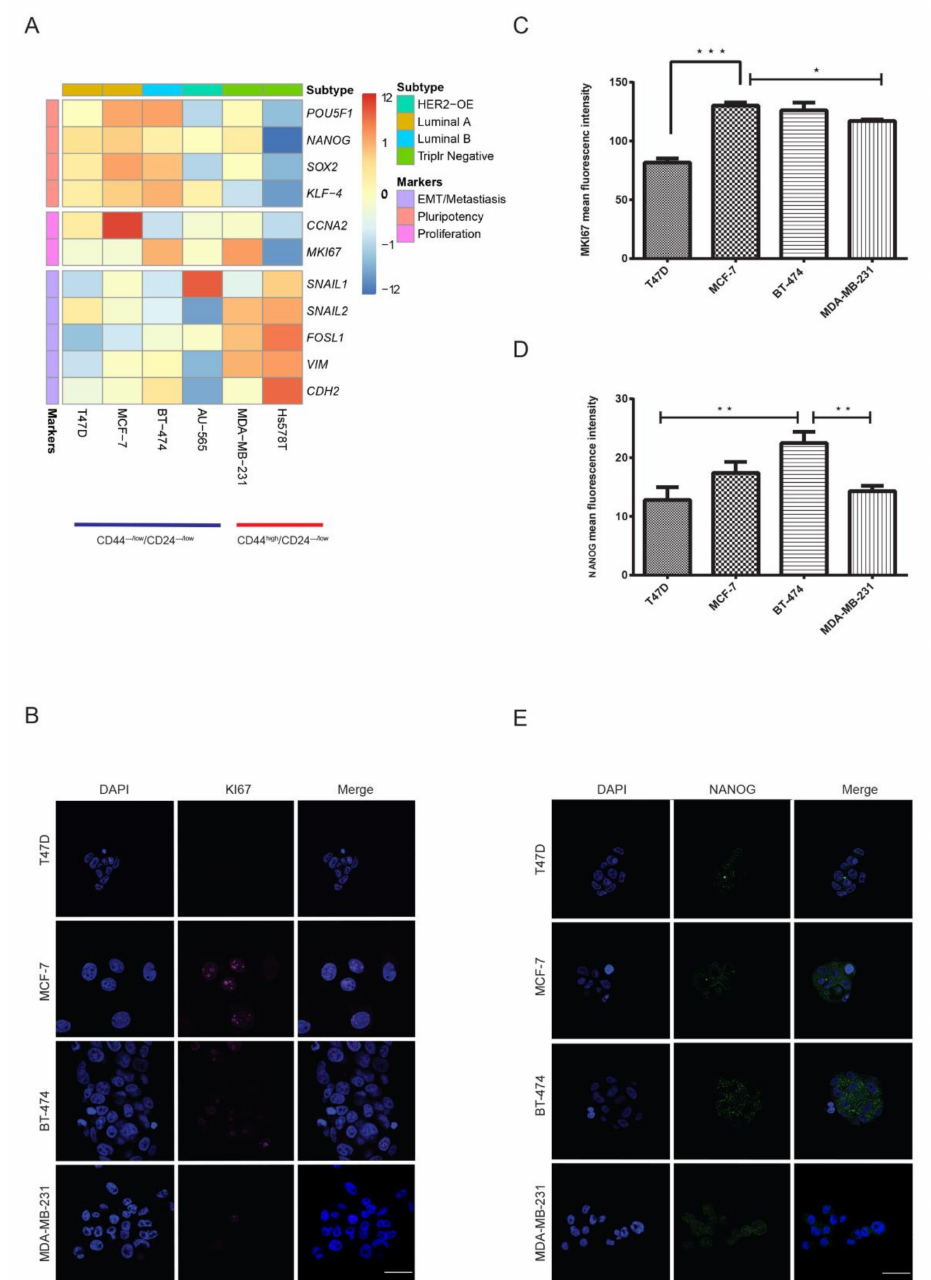
Figure 3. Luminal CD44 − / low / CD24 − / low cells show a similar expression profile of pluripotency markers. Comparison of mRNA expression of markers for pluripotency, EMT / metastasis and proliferation for CD44 high / CD24 − / low and CD44 − / low / CD24 − / low cells, performed using qRT-PCR. ( A ) Heat map of genes with opposite expression patterns between CD44 high / CD24 − / low and CD44 − / low / CD24 − / low for pluripotency and EMT. Each row represents an RNA transcript; each column represents a cell line. CD44 − / low / CD24 − / low cells from luminal cell lines overexpressed pluripotency markers (Supplementary Figure S3). Representative image and analysis of immunofluorescence for MKI67 ( B , C ) and NANOG ( D , E ) expression in mammospheres from CD44 − / low / CD24 − / low and CD44 high / CD24 − / low cells. Flow cytometry sorted cell populations were maintained as spheres for 14 days and stained with DAPI (blue), NANOG (green) and MKI67 (magenta). Spheres were observed under fluorescence microscope. Data represent the mean ± SD (n = 3) of three independent experiments; * p < 0.05, ** p < 0.01 and *** p < 0.001. Scale bar = 100 µ